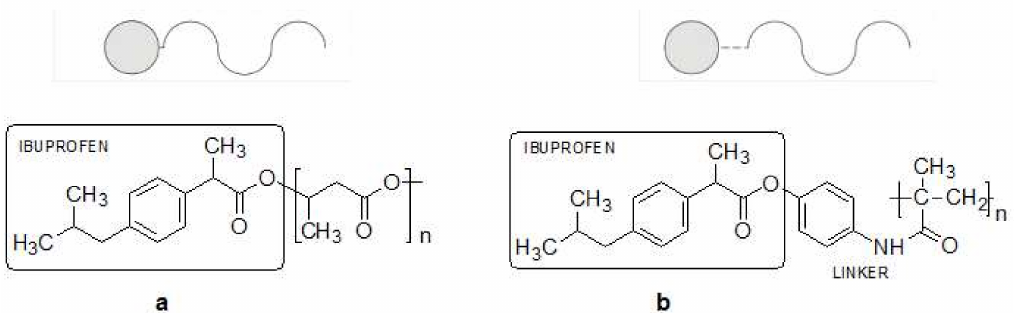
Figure 12. Polymer-drug conjugates (PDCs); ( a ) no-linker mode, ( b ) linker